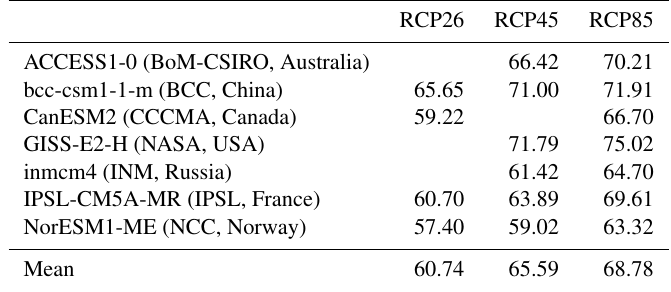
Table A4. Mean of the maximum wind speed of synthetic cyclones in representative representation pathways (ms − 1